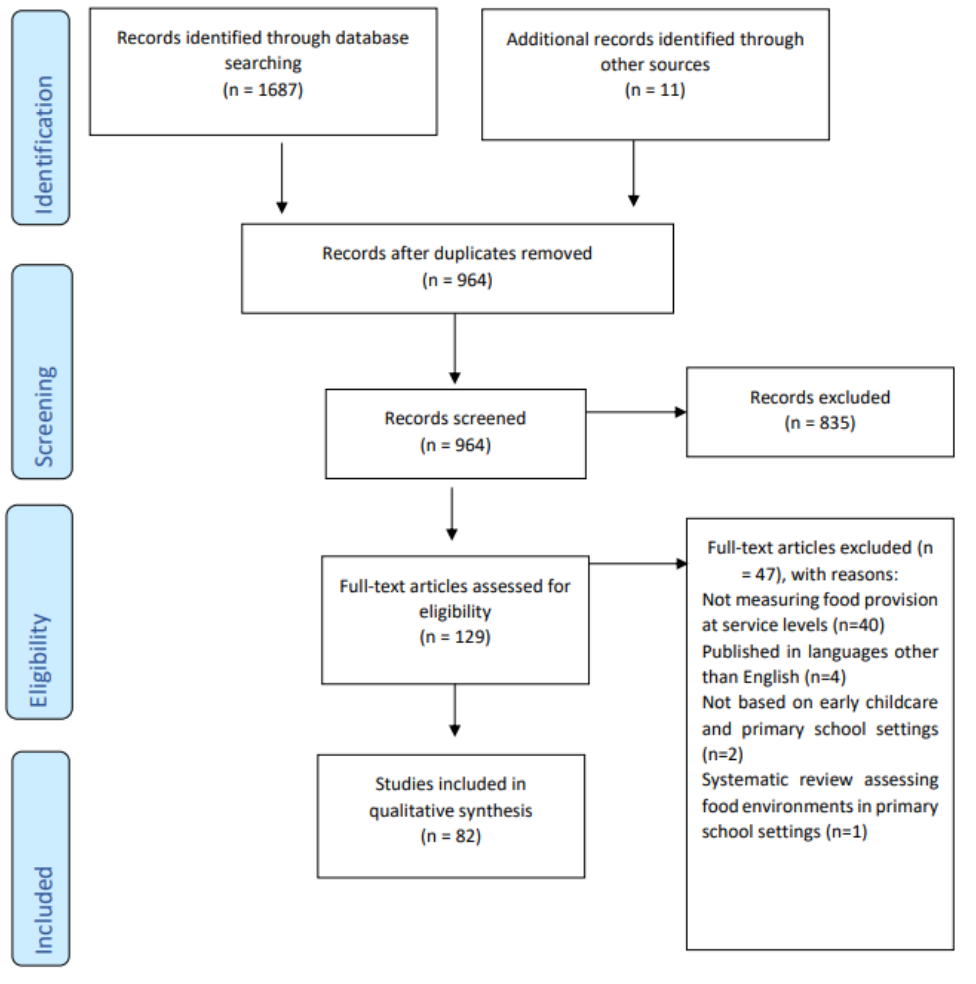
Figure 1. PRISMA flow